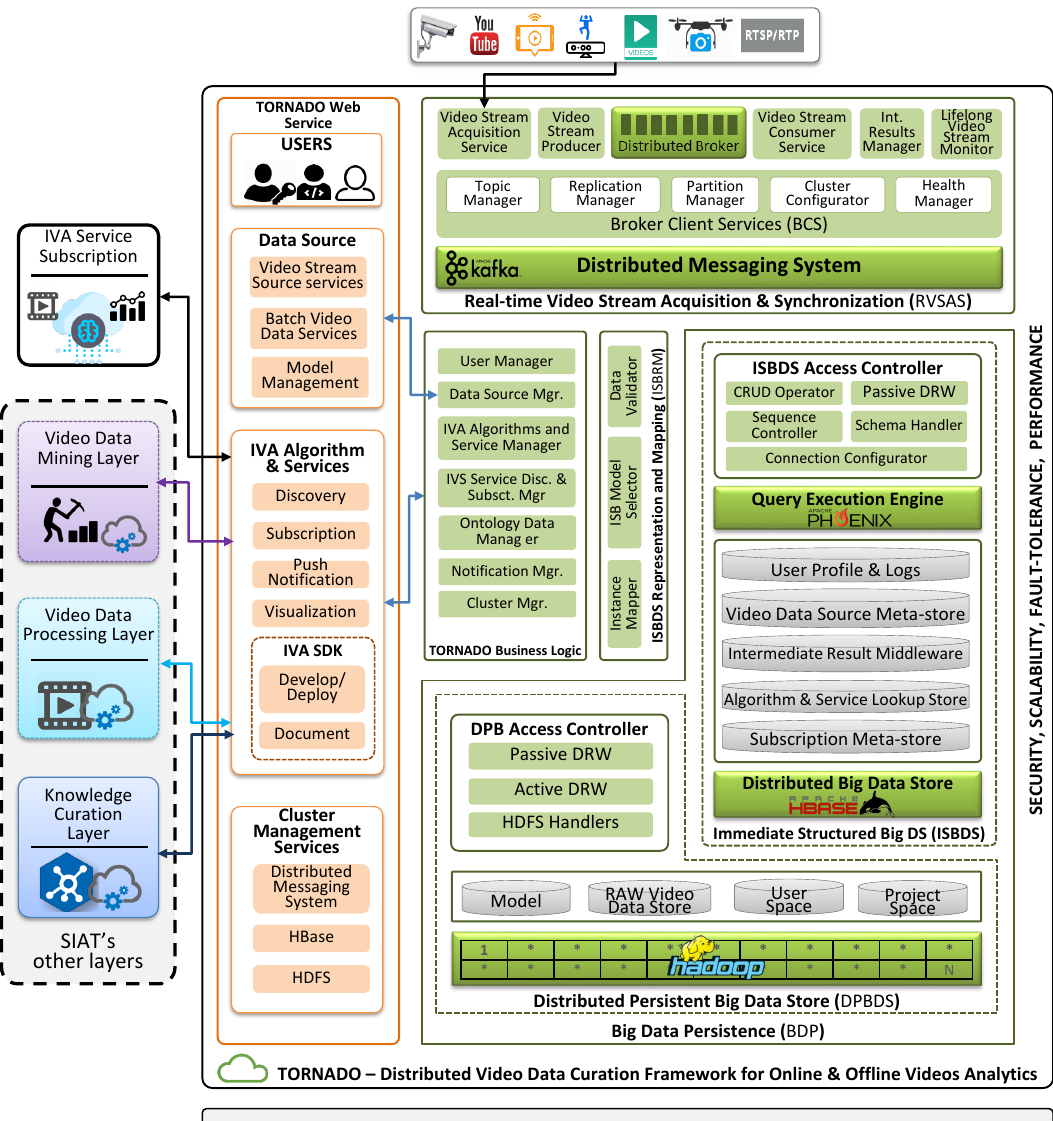
Figure 3. Proposed TORNADO framework